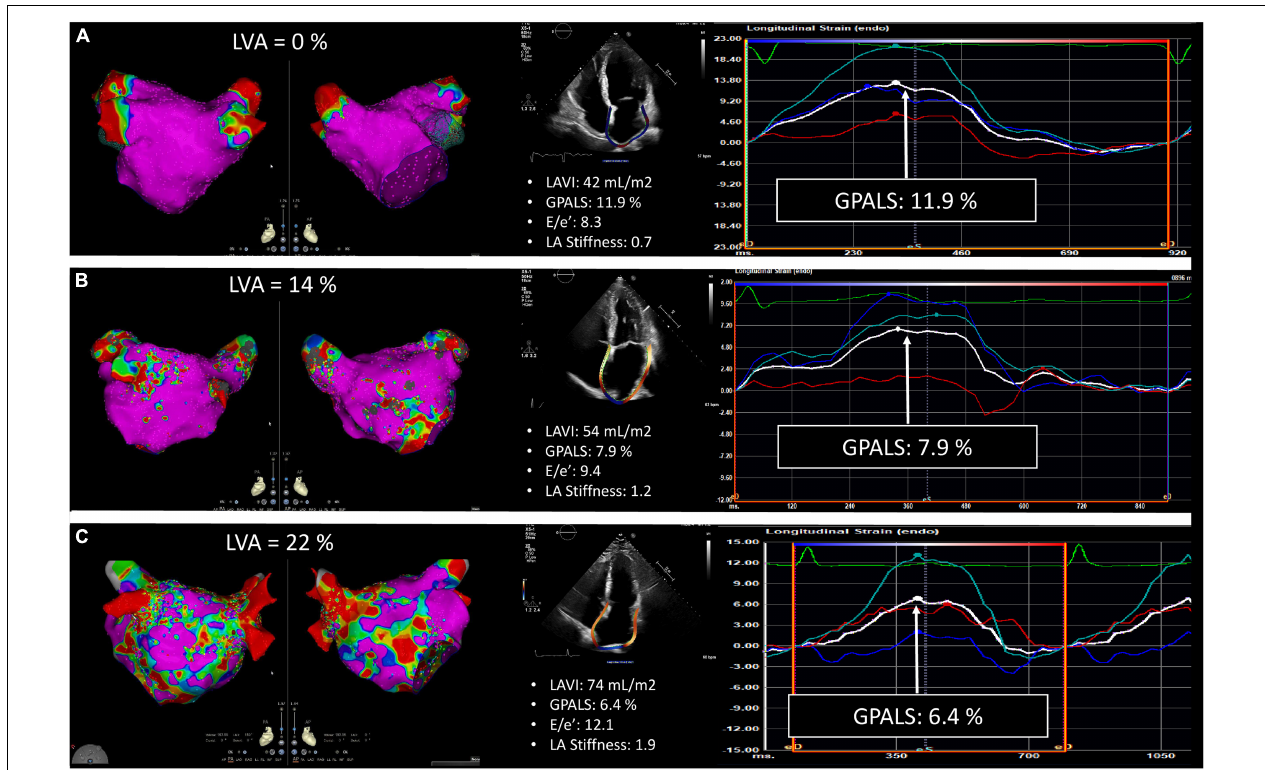
FIGURE 1 | Representative example of echocardiographic strain analysis performed in three patients with different severity of left atrial (LA), low-voltage area (LVA) extent. Group I: no LVA (A) , group II: moderate LVA extent (B) , and group III: important LVA extent (C) . The color gradient of the LVA maps indicates electrogram amplitude from pink ( > 0.5 mV in SR and > 0.31 in AF) to red at < 0.1